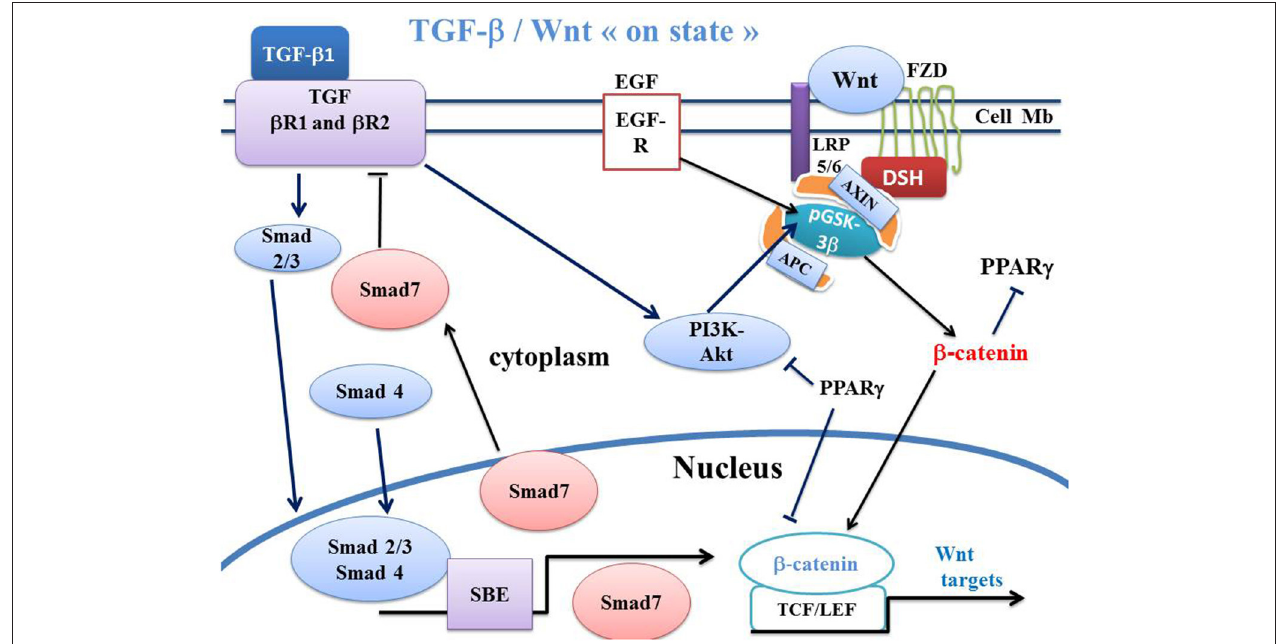
FIGURE 2 | Schema of canonical Wnt/ β -catenin, TGF- β , SMAD pathways and PPAR γ in Wnt “on state.” In canonical Wnt signaling “on state,” TGF- β 1 binds the type 2 TGF- β R2 receptor (TGF- β R2), Thus, TGF- β R2 recruits the type 1 TGF- β R1 receptor (TGF- β R1). This induces the formation of a heterotetramer that phosphorylates Smad. The Smad complex then translocates to the nucleus and regulates the transcription of Smad target genes. Smad7 in turn inhibits the TGF- β R1-R2 receptors. The PI3K-Akt pathway is a non-Smad signaling which is activated by TGF signaling and which induces phosphorylation of GSK-3 β . PPAR γ inhibits PI3KAkt and the β -catenin/TCF-LEF-induced activation of WNT target genes. APC, adenomatous polyposis coli; DSH, Disheveled; FZD, Frizzled; GSK-3 β , glycogen synthase kinase-3 β ; LRP5/6, low-density lipoprotein receptor-related protein 5/6; PPAR γ , peroxisome proliferator-activated receptor gamma; PI3K, phosphatidylinositol 3-kinase; Akt, Akt/Protein Kinase B; TCF/LEF, T-cell factor/lymphoid enhancer factor; TGF, Transforming Growth Factor; SBE, Smad binding element; EGFR, Epidermal growth factor